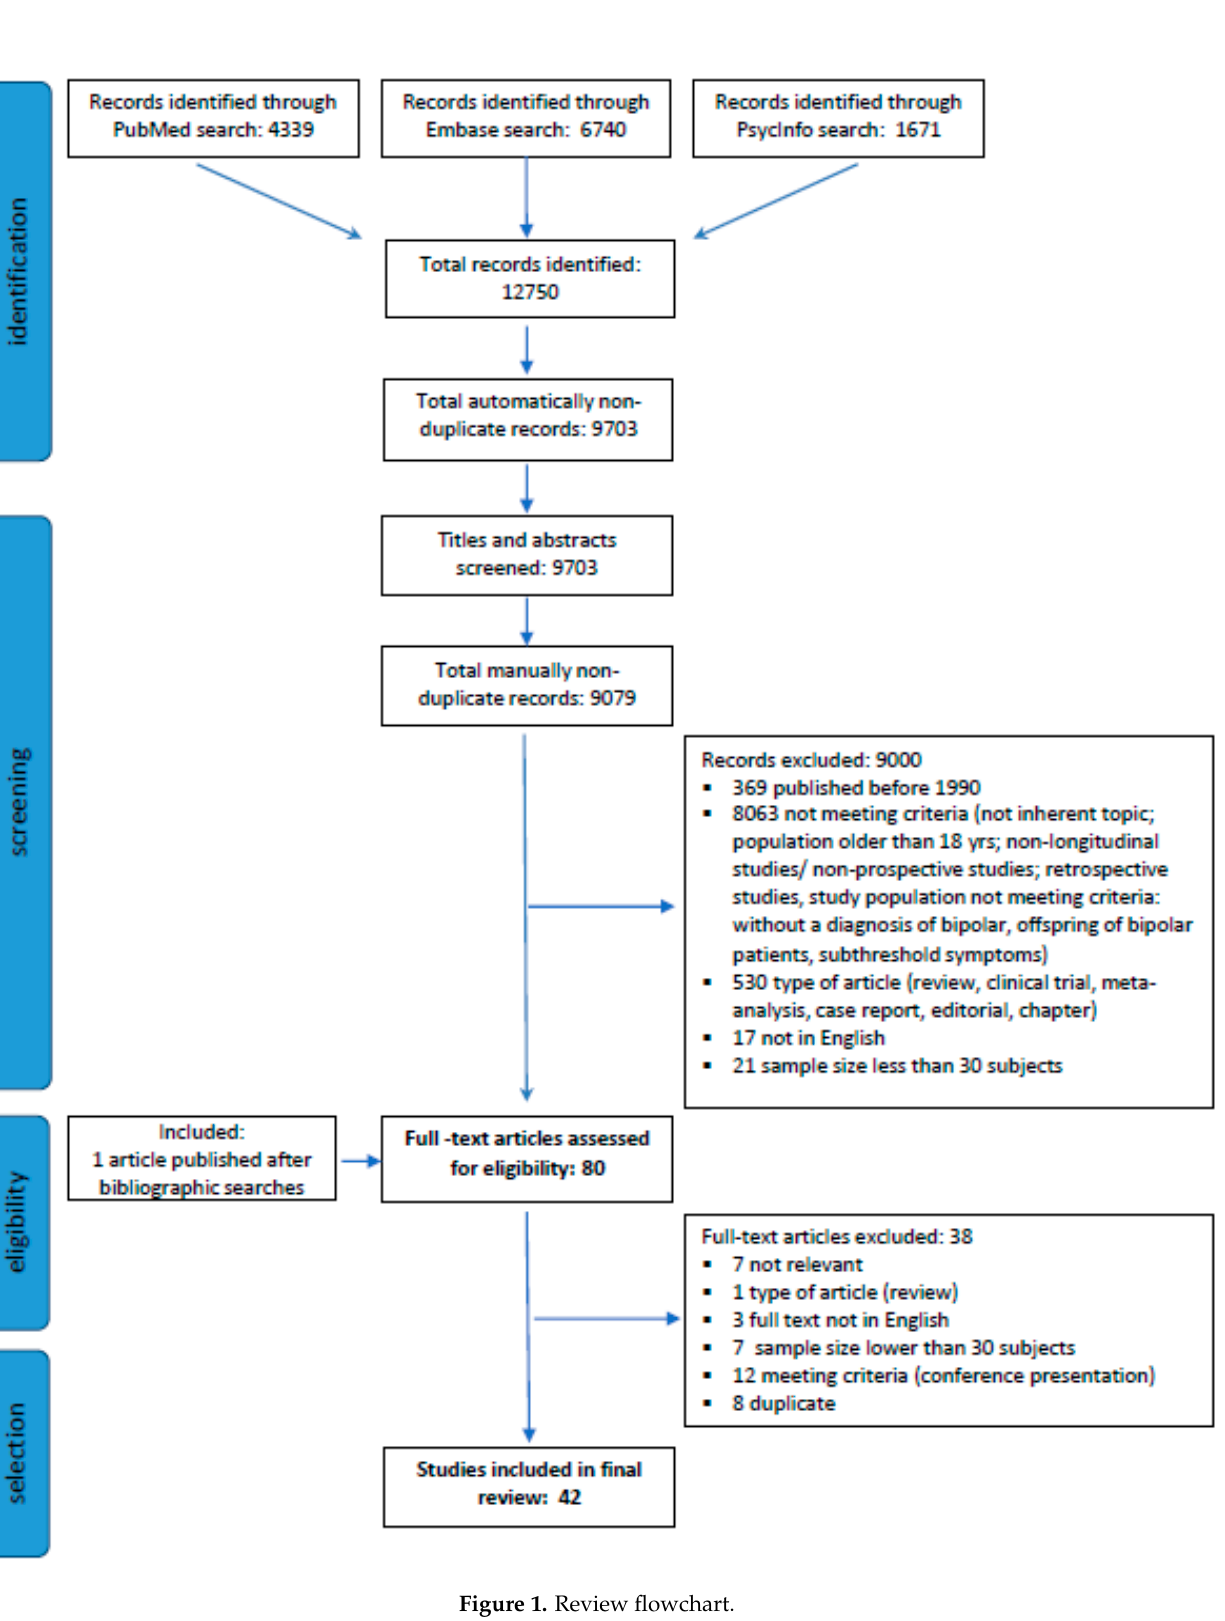
Figure 1. Review Figure 1. Review flowchart.